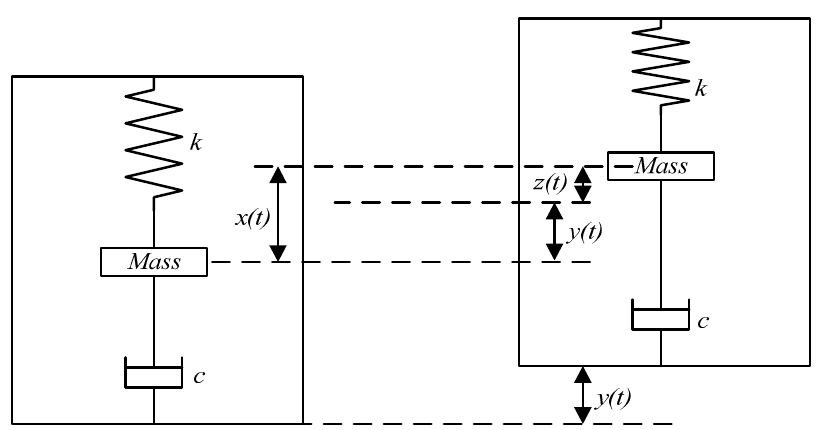
Figure 12. Generic model of kinetic energy harvesters.